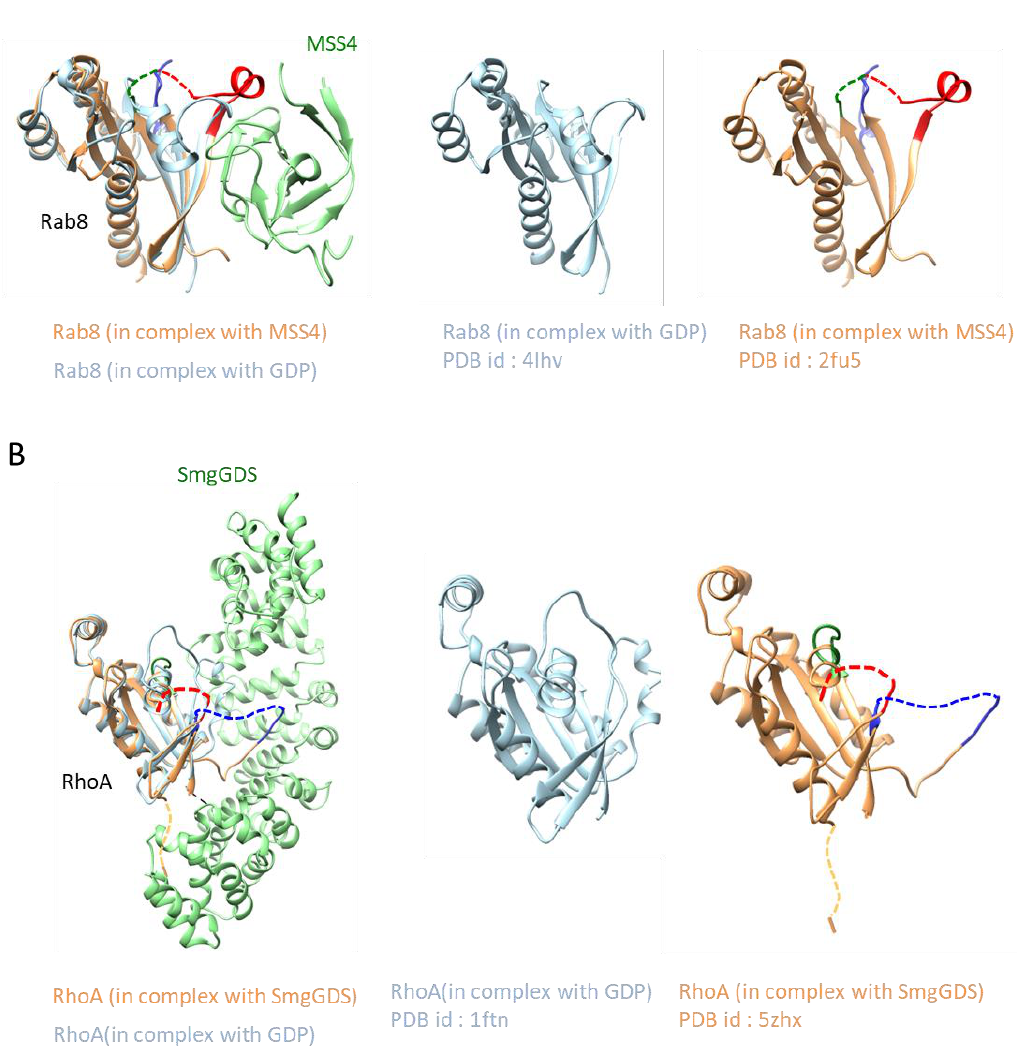
Figure 6. Local protein unfolding and refolding mechanism: ( A ) Structures of Rab8 in a complex with MSS4 and GDP-bound form and ( B ) Structures of RhoA in a complex with SmgGDS and GDP-bound form. The nucleotide recognition regions (P loop, switch I, and switch II) are almost ordered in the unbound form, but these regions are largely disordered in both proteins upon binding of the regulator. Disordered regions are shown as dashed lines. The color scheme and other descriptions follow those of Figure 1B.